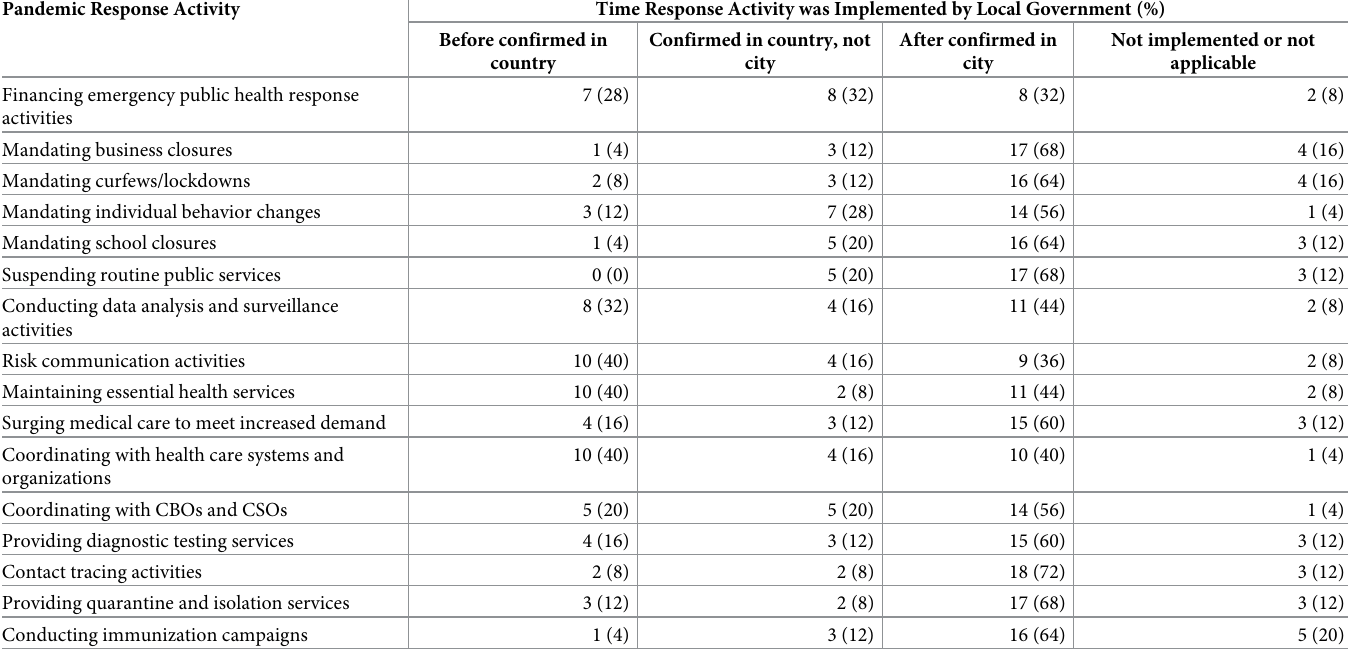
Table 2. Time that pandemic response activities were implemented by local governments (n = 25); Community-based organizations (CBOs), Civil society organi- zations (CSOs). Pandemic Response